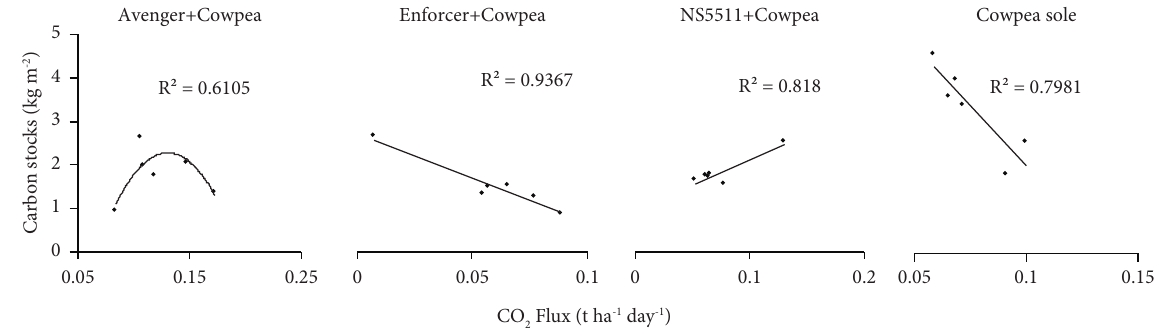
Figure 18: Carbon stocks ( y -axis) versus CO 2 emission rates ( x -axis) of sorghum and cowpea in binary and sole cultures at Ofcolaco during the 2020/21 cropping